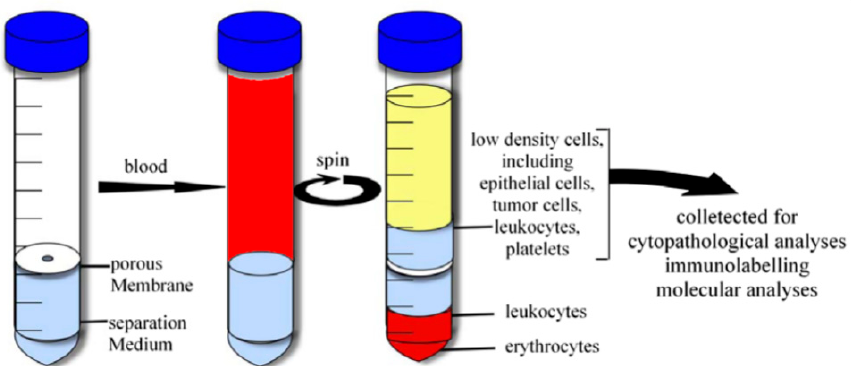
Figure 6. Cell separation by gradient centrifugation method with OncoQuick separation kit. with permission from [180]. Copyright 2007, Reprinted with permission from [180] . Copyright 2007, Elsevier.